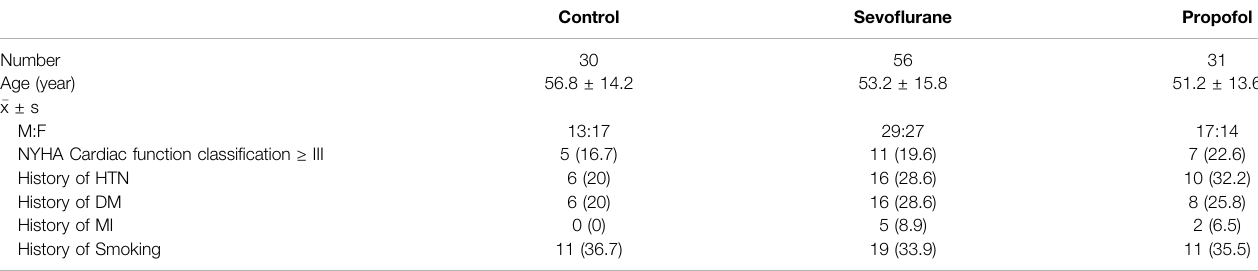
TABLE 2 | Demographic characteristics of Groups (%).